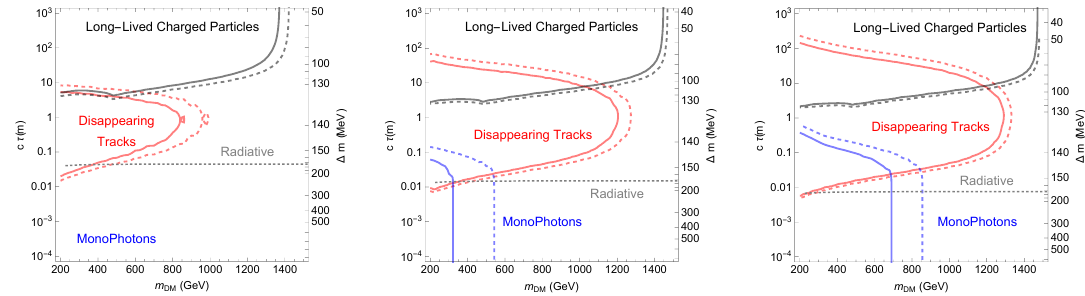
Figure 12 . Combined exclusion and discovery plots for scalar EMDM in the mass-lifetime plane for, from left to right, the real scalar triplet, quintet, and septet respectively. The notation is as in (cid:12)gure